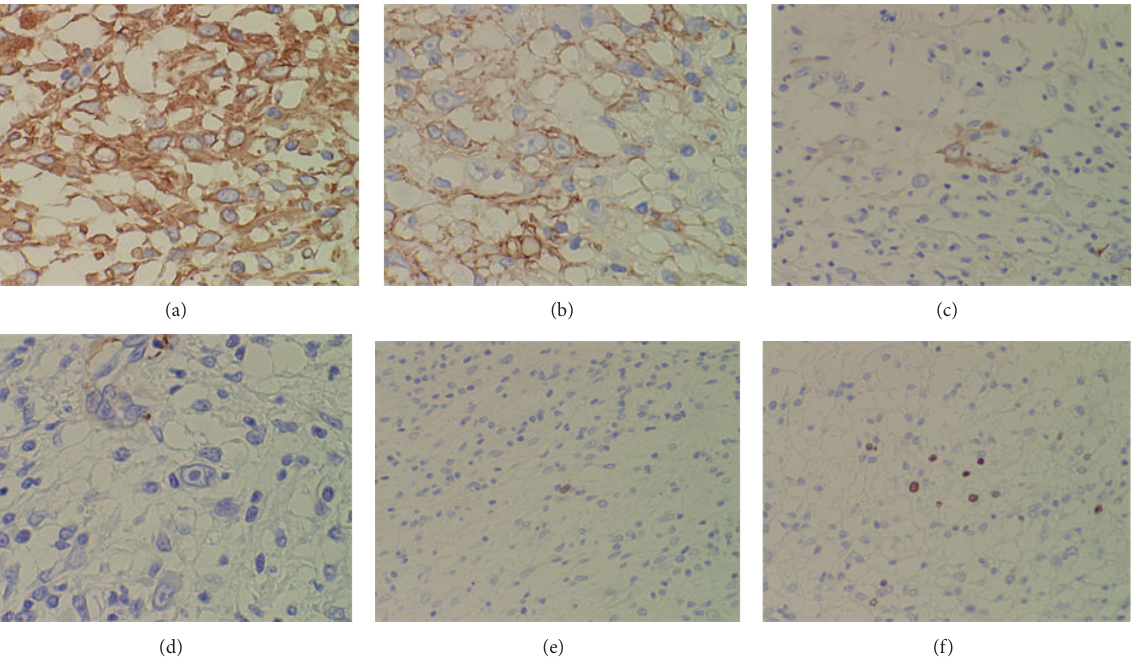
Figure 5: Immunohistochemistry against various antibodies. Sarcoma cells are positive for vimentin (a) and CD34 (b). A few tumor cells are positive for CD68 (c) and S-100 (d). Positive rates of nuclear p53 (e) and MIB-1 (f) were 1% and 7.5%, respectively. Immunohistochemistry,